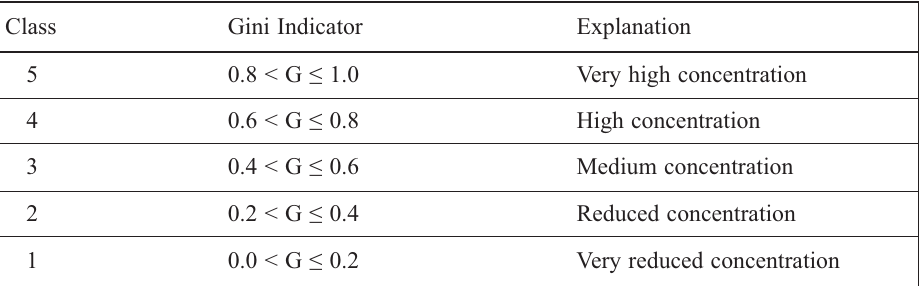
Table 2. The concentration degrees after the Gini